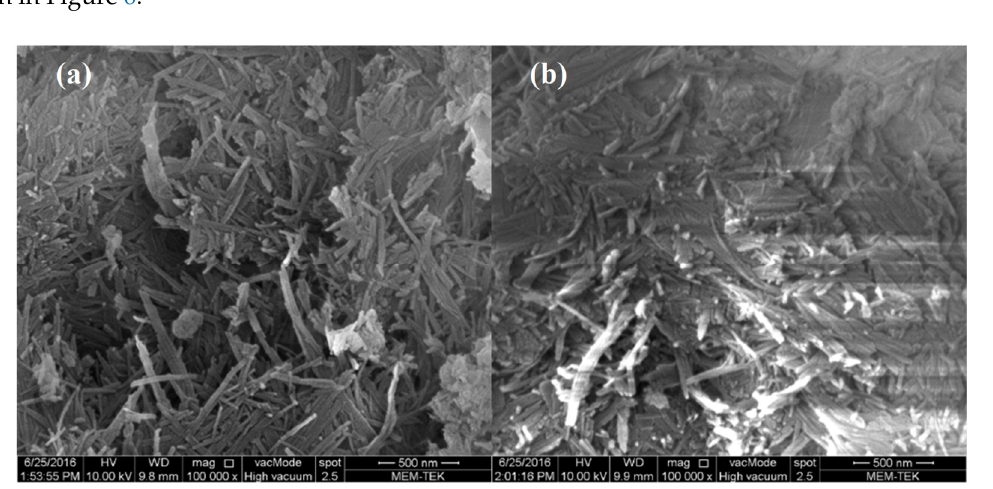
Figure 6. ESEM images for natural ( a ) and modified ( b ) sepiolite samples, respectively.